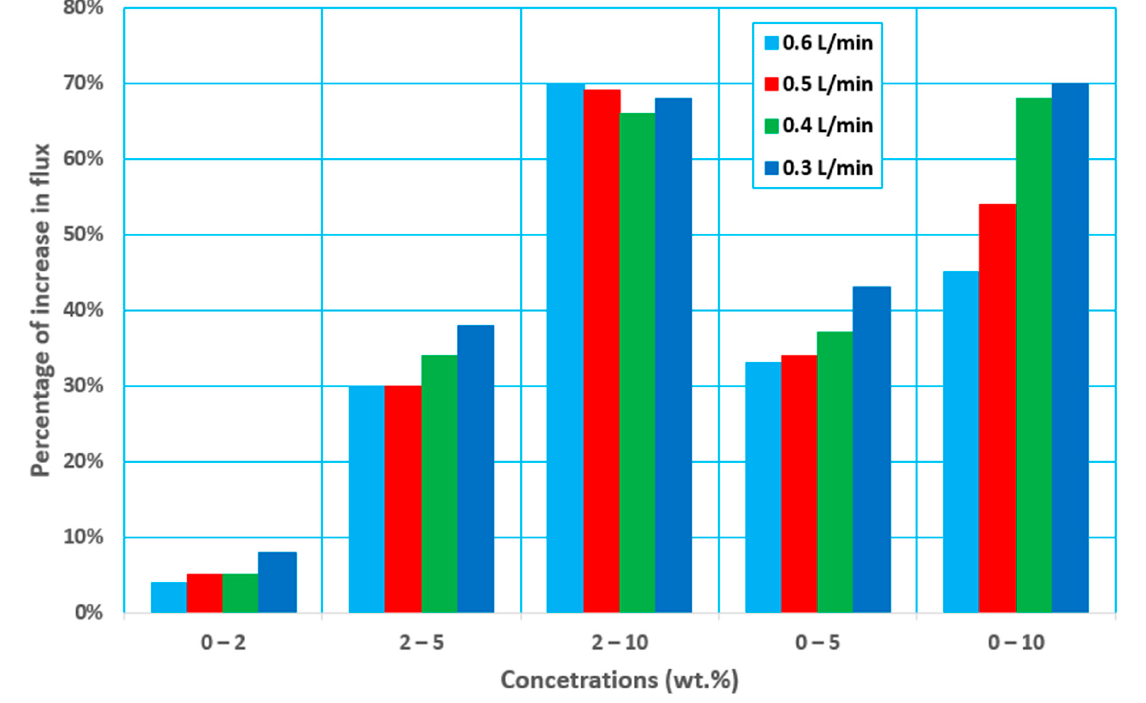
Figure 10. Percentage decrease in permeate flux with an increasing initial ethanol concentration at a feed temperature of 30 °C, 60 mmHg (abs) pressure, and various flow rates.